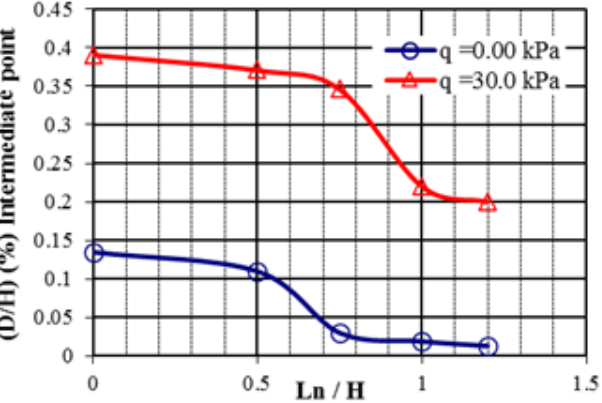
Figure 6. Effect of nail length on the horizontal movement of the middle of the slope.